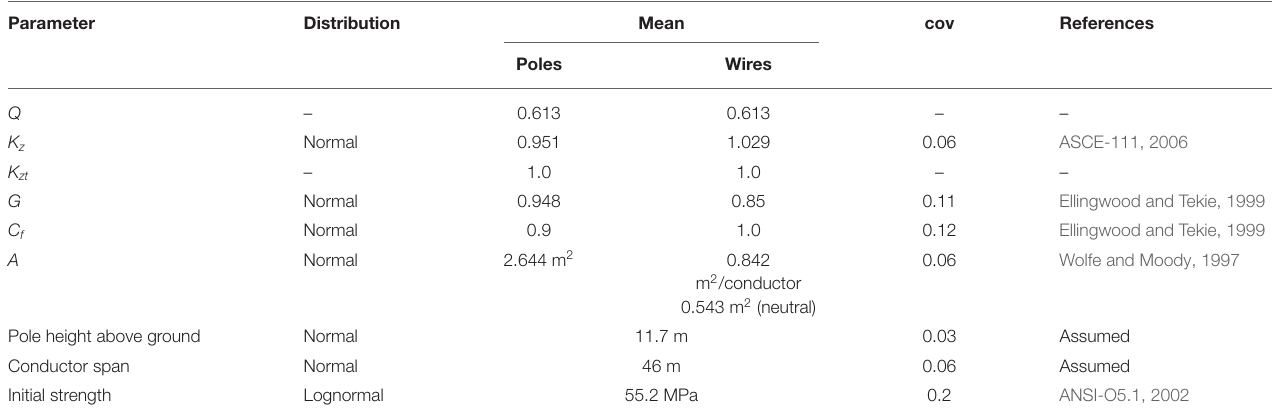
TABLE A1 | Statistical parameters for fragility